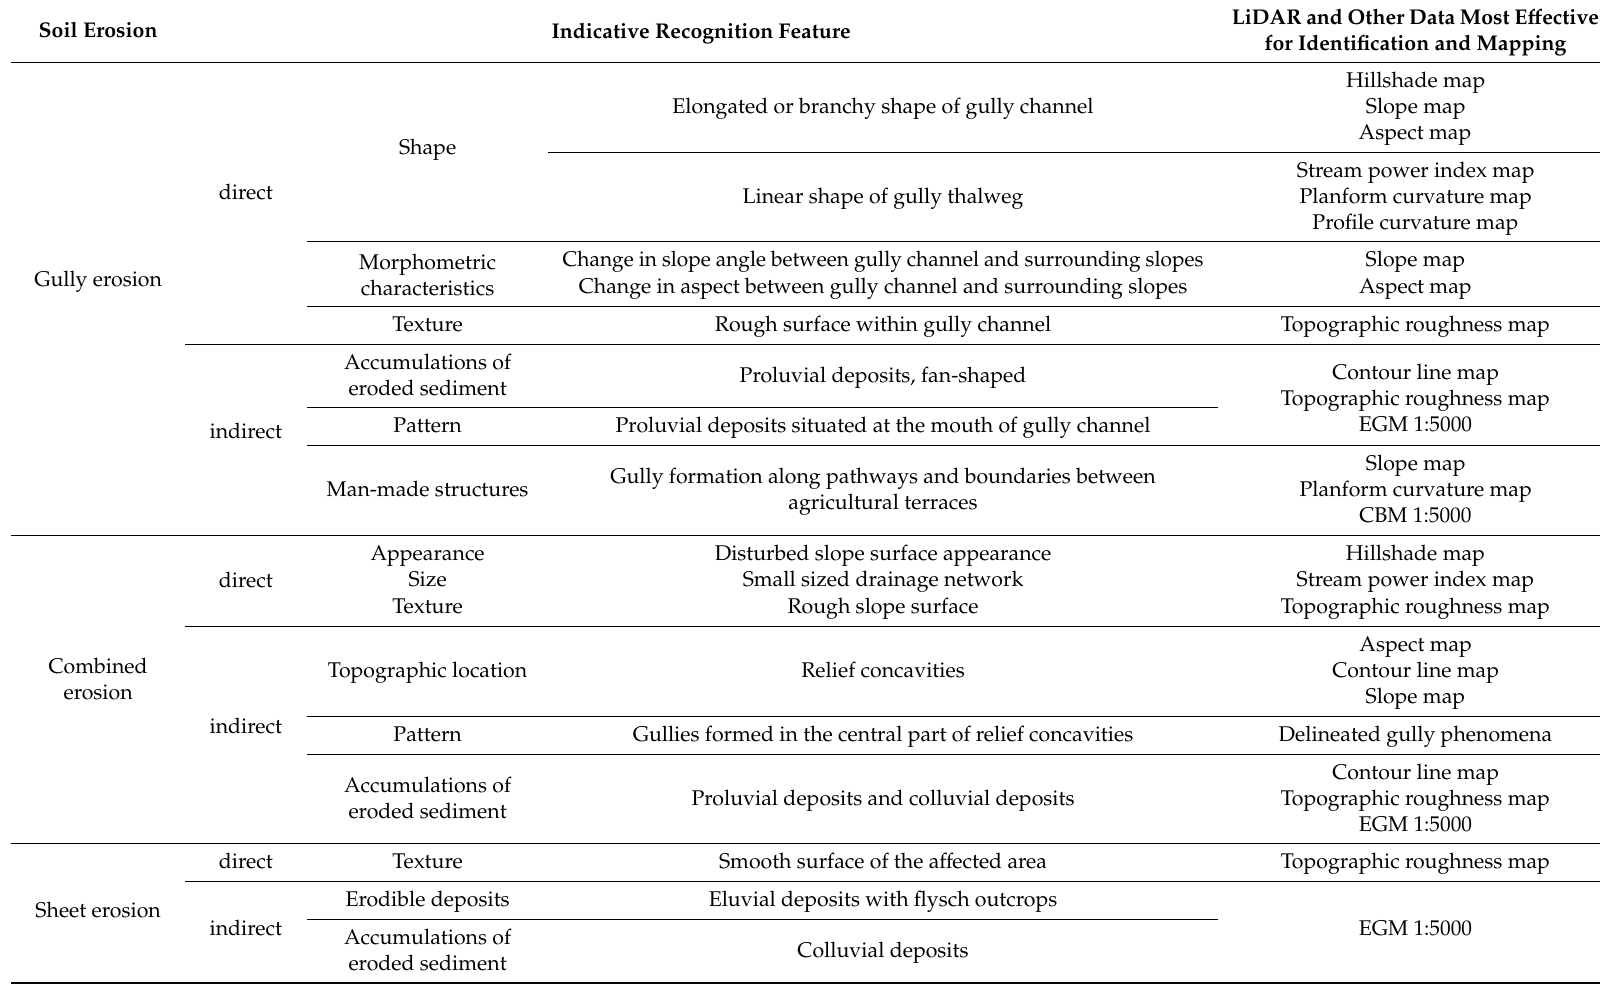
Table 1. Criteria for identification and mapping of soil erosion